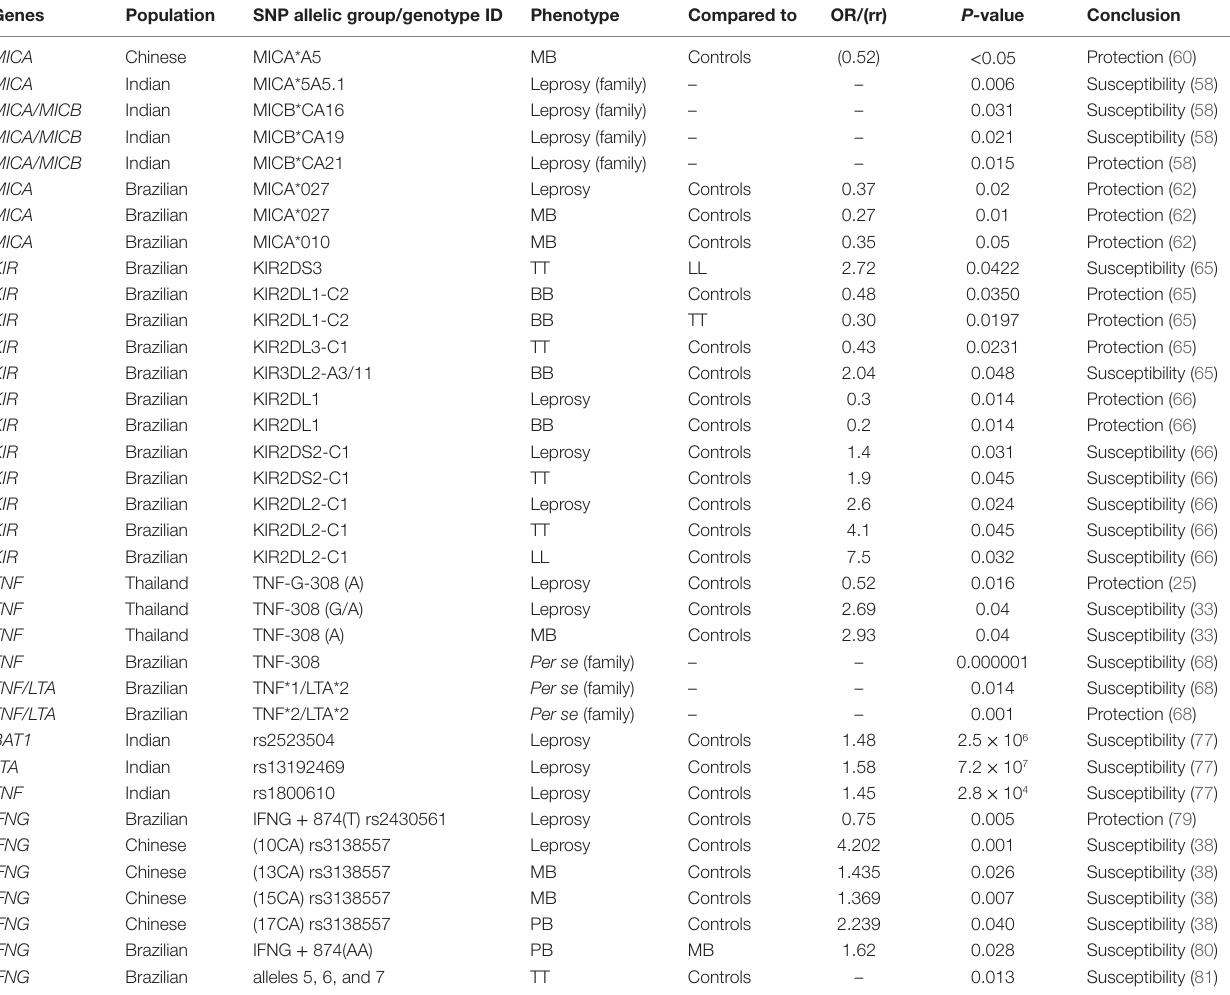
TABLe 3 | Summary of associations between genes of innate immune response MICA , MICB , KIR , TNF , LTA , BAT1 , IFNG , and